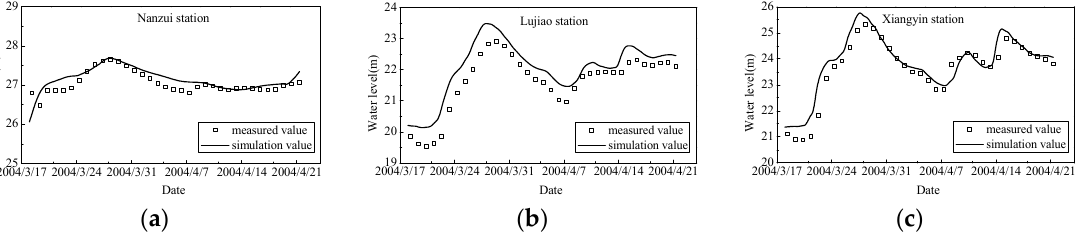
Figure 3. Comparisons of time series of water elevation between predictions and measurement during the normal season. ( a ) the Nanzui station; ( b ) the Lujiao station; ( c ) the Xiangyin station.